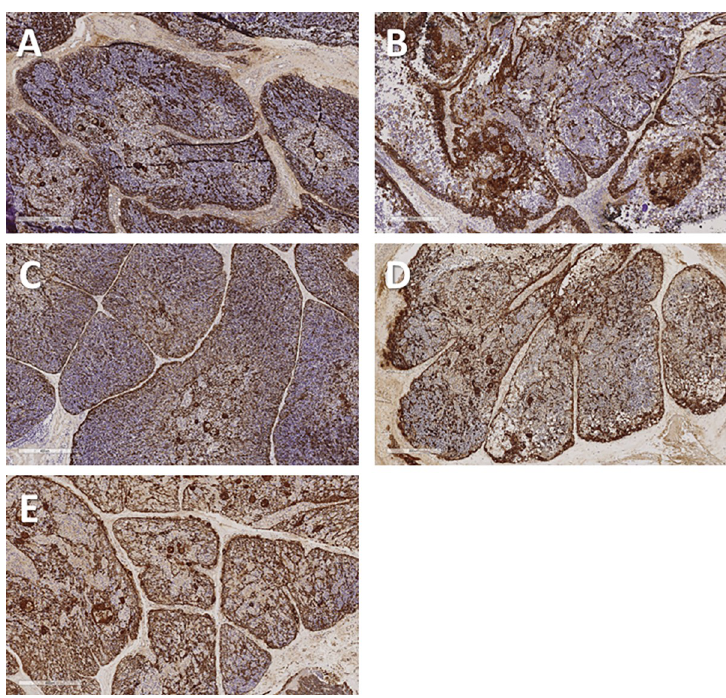
Fig 8. Comparison of thymic epithelial network of cultured thymus tissue at different time points. A. Day 0. B. Day 5. C. Day 9. D. Day 12. E. Day 21. Although there are time point-related differences in thymocyte depletion and the amount of necrosis such that the tissue become less basophilic (blue color) with time, the structure of the thymic epithelial network (brown color) remains intact as the culture progresses. Both cortical and medullary epithelium may condense as intervening thymocytes are depleted. Brown color indicates a positive reaction with a cocktail of anti- cytokeratin antibodies (AE1 + AE3); Hematoxylin counterstain. Bar represents 400 μ m.